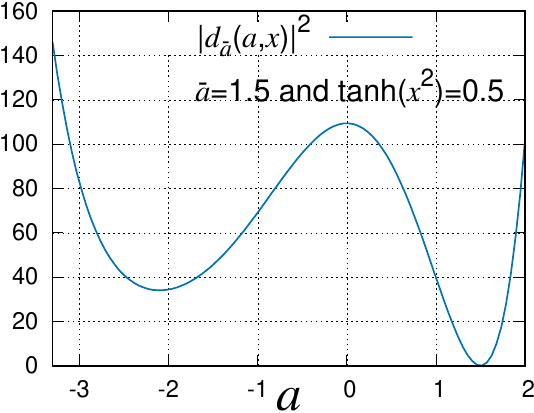
Figure 7. The function | d ¯ a ( a , x ) | 2 (¯ a = 1.5) is plotted when tanh ( x 2 ) = 0.5.